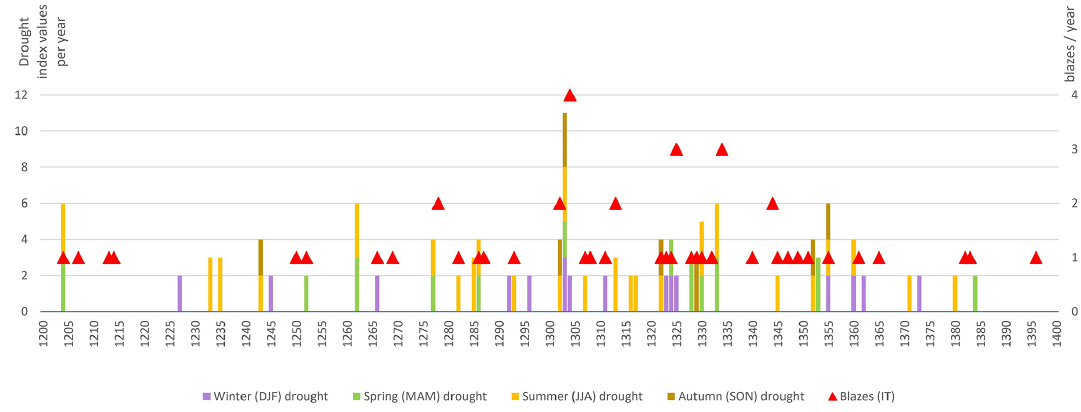
Figure 8. Reconstruction of drought indices compared with a chronology of fires for IT, 1200–1400. Data are available for 64 years out of 200 (32% coverage).